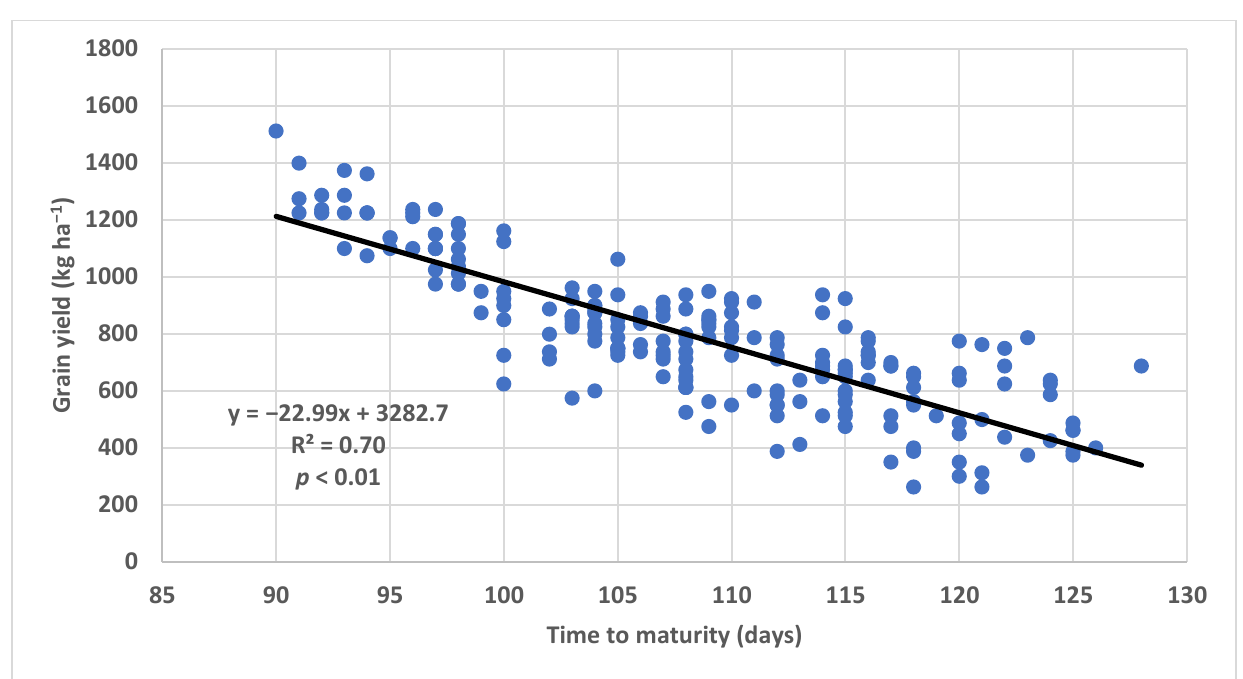
Table 3. Average sorghum straw yield (kg ha −1 ) across sites of flood recession farming for 54 varie- ties tested in Yaguine, Gory, and Foungou in the 2013/2014 cropping season. Varieties with letters that do not overlap (A to M) are significantly different.